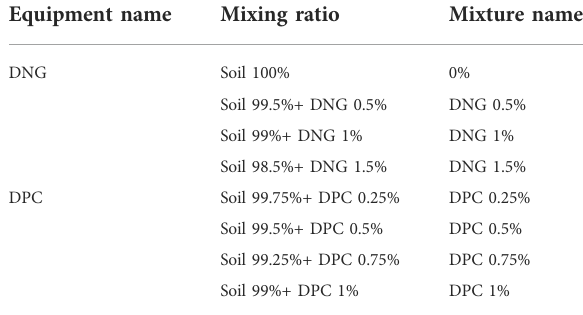
TABLE 2 Nomenclature of PPE and silty sand mixtures.